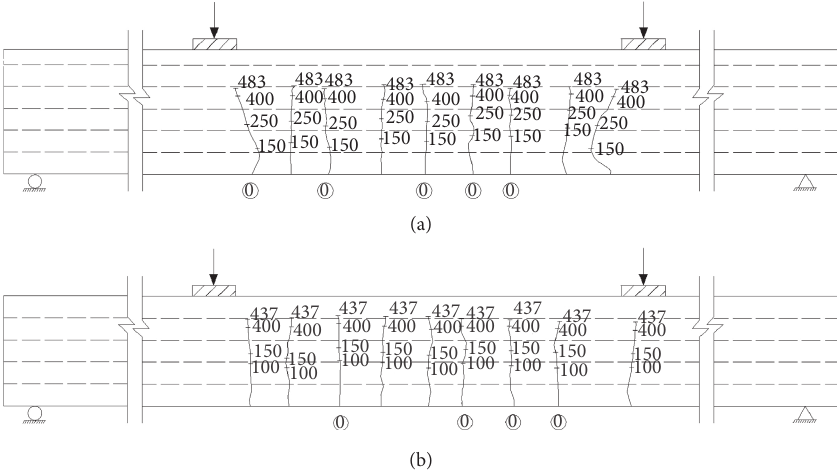
Figure 7: Distribution pattern of web cracks: (a) JD1; (b) JD2.